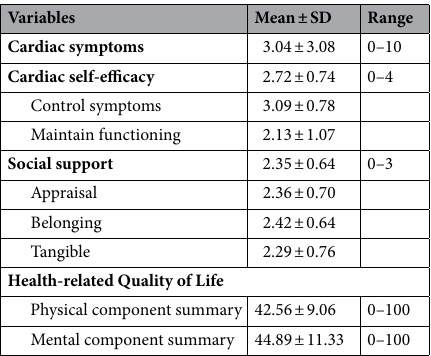
Table 2. Descriptive statistics of cardiac symptoms, cardiac self-efficacy, social support, and health-related Quality of Life (N =